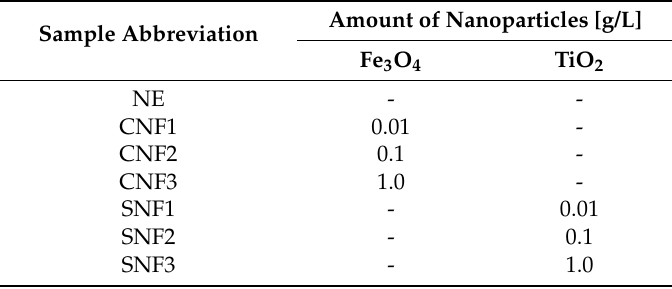
Table 1. Weight fraction of nanofluid formulation samples.